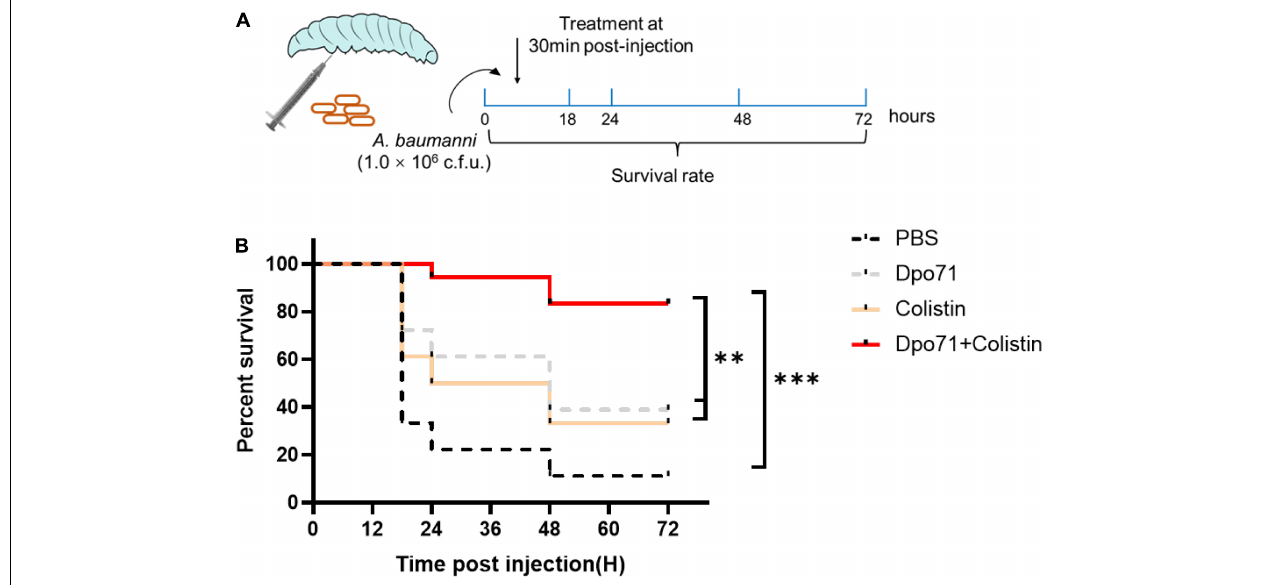
FIGURE 7 | Antivirulent activity in the Galleria mellonella infection model. (A) Scheme of the experimental protocol for the G. mellonella. (B) Survival curves for G. mellonella infected with 10 6 CFU A. baumannii then followed by the injection of PBS buffer (control group); 5 µ g Dpo71; 1 µ g colistin; or 1 µ g colistin + 5 µ g Dpo71 (treatment group) ( n = 18, ∗∗ p < 0.01, ∗∗∗ p < 0.001, Kaplan–Meier survival analysis with log-rank